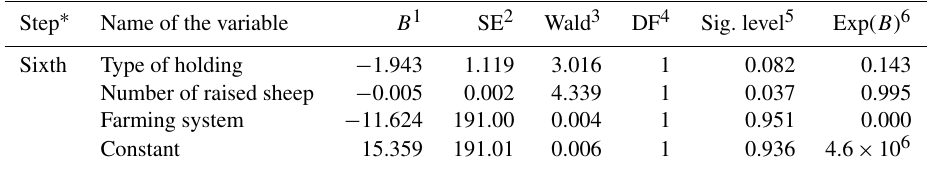
Table 3. Logistic regression results (sixth step) for the effects of the structural characteristics of the holdings on the breeders’ daily work